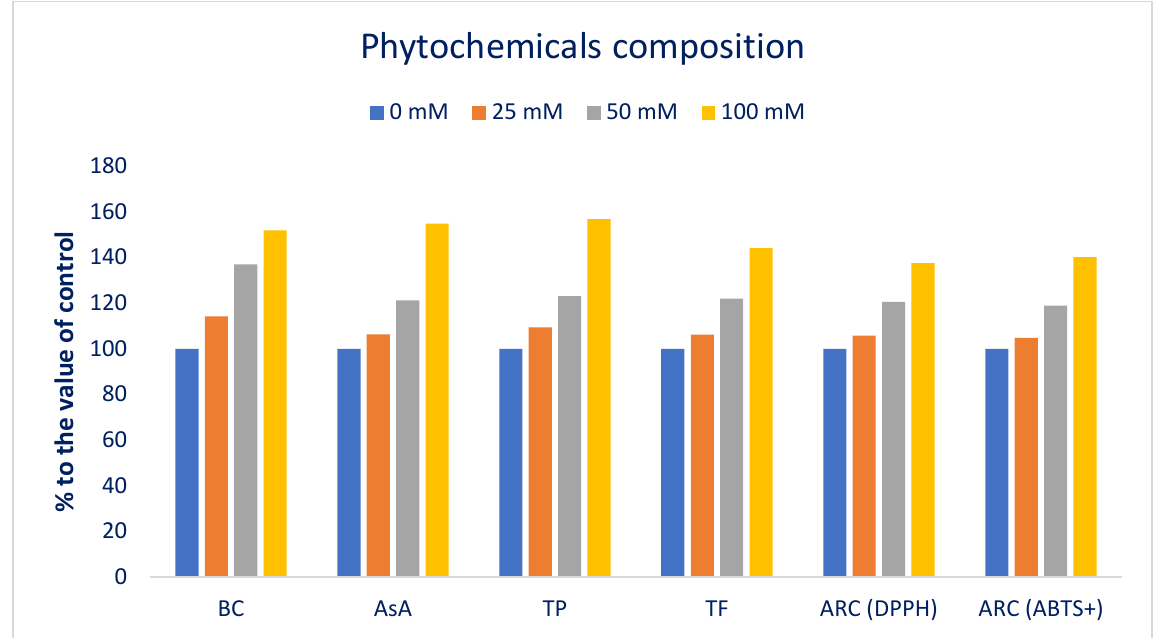
Figure 8. Comparison of the salt-induced increment in phytochemical composition (%) over control in Lalshak.